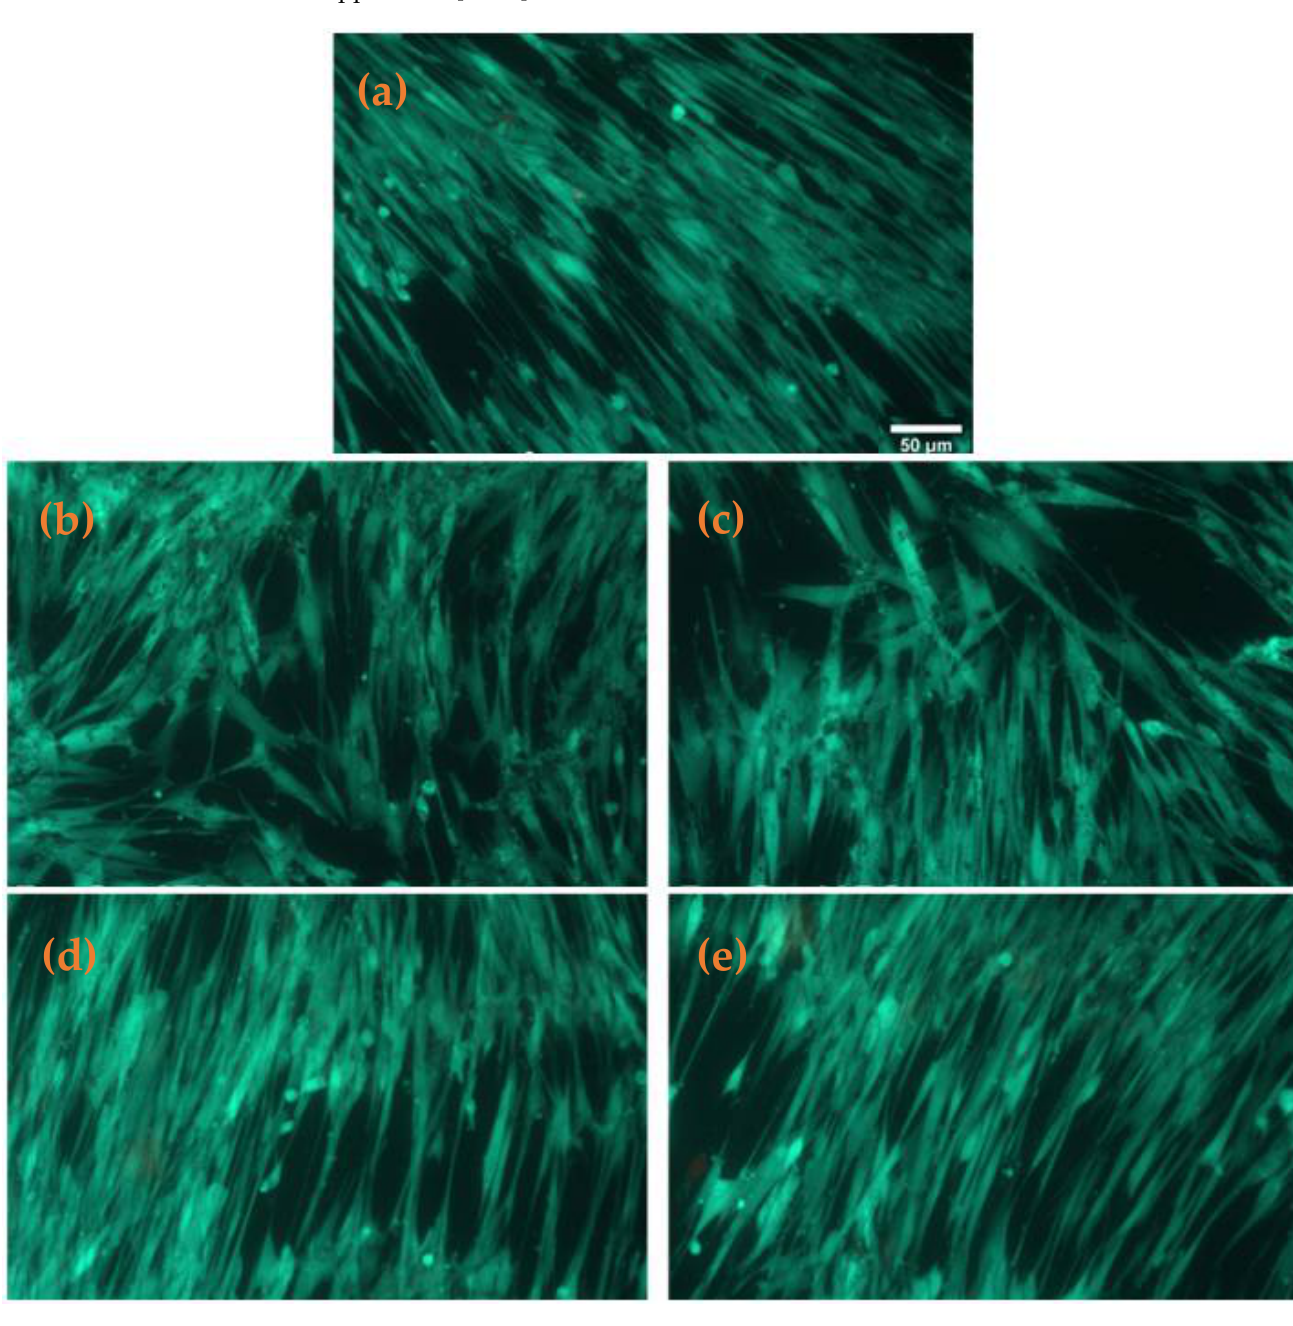
Figure 10. Fluorescence images of live (green) and dead (red) cells stained with calcein AM and ethidium, respectively, after 24 h incubation of MRC-5 human fibroblasts with ( a ) control, ( b ) Fe 3 O 4 @STR, ( c ) Fe 3 O 4 @NEO, ( d ) PLGA-CS-Fe 3 O 4 @STR and ( e ) PLGA-CS-Fe 3 O 4 @NEO spheres (scale bar is 50 μm and it is the same for all images).